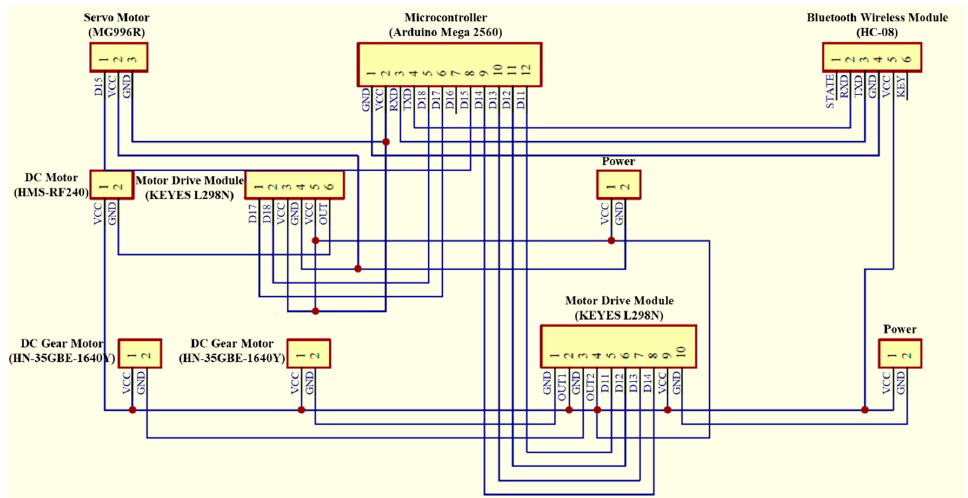
Figure 12. Circuit diagram of the water surface cleaning system and locomotion module.